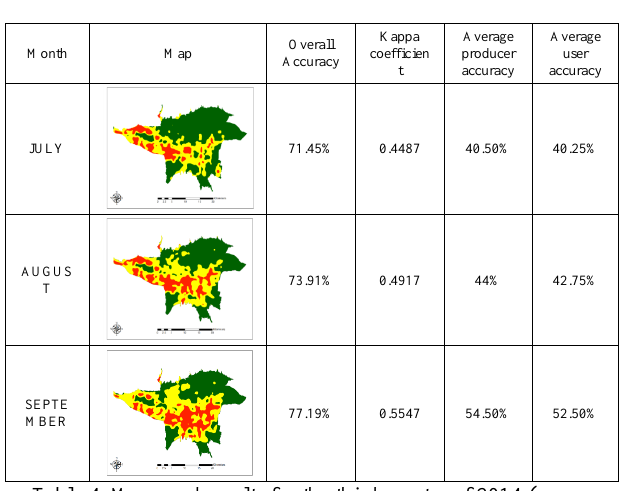
Table 3. Maps and results for the second quarter of 2014 (green: Clear, Yellow: low density, red: high density)